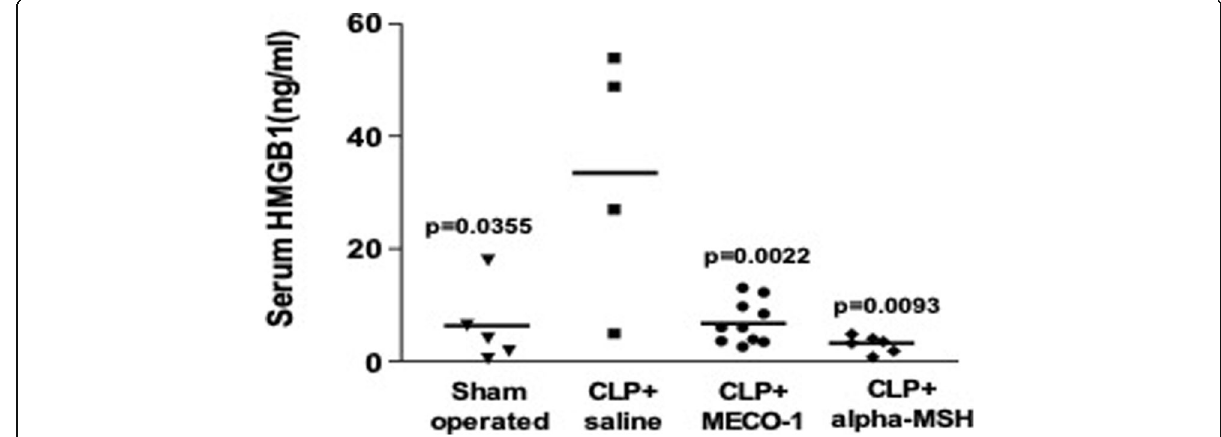
Fig. 5 MECO-1 and α -MSH as anti-HMGB1 corticotropic peptides. Figure used with permission from authors (Qiang et al. 2017). Melanocortin-like peptide of E. coli -1 (MECO-1) has anti-inflammatory effects similar to α -melanocyte-stimulating hormone ( α -MSH) and adrenocorticotropin (ACTH), two prominent mammalian melanocortin hormones. HMGB1, the proposed major inflammatory mediator of the post-sepsis syndrome, remained elevated in septic mice treated with saline alone. MECO-1 and α -MSH were equally effective in attenuating the release of HMGB1 from macrophage-like cells in septic mice. The model for sepsis used was cecal ligation and puncture